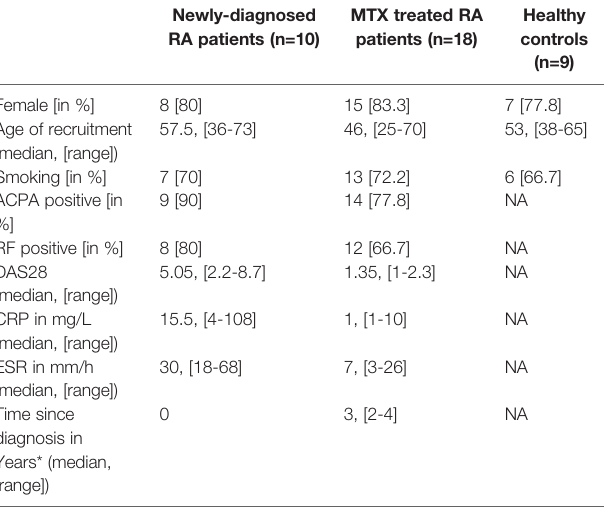
TABLE 1 | Summary of demographic and clinical characteristics in the study phenotypes.